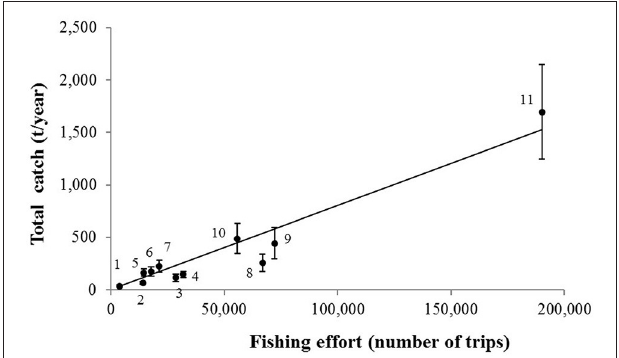
FIGURE 2 | Regression ( y = 0.008 x , R 2 = 0.927) of estimated total annual catch and fishing effort of the shallow water fisheries not destined for export in 11 island groups in Vanuatu in 1984. Conservative 95% confidence intervals are represented. The taxonomic composition of the catch includes finfish, mollusks and lobsters. Derived from data from David (1991). (1) Paama Island; (2) Ambrym Island; (3) Ambae & Maewo Island; (4) Sheperds Island; (5) Pentecost Island; (6) Epi Island; (7) Sanma Province; (8) Torba Province; (9) Tafeo Province; (10) Efate Island; (11) Malekula